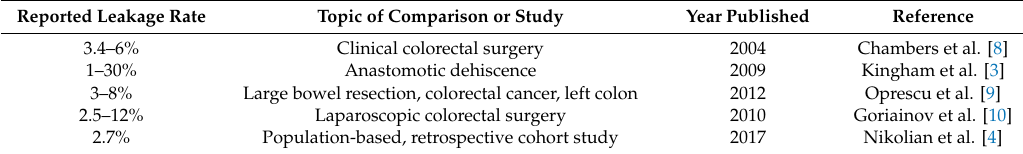
Table 1. Reported rates of anastomotic leakage of different studies.